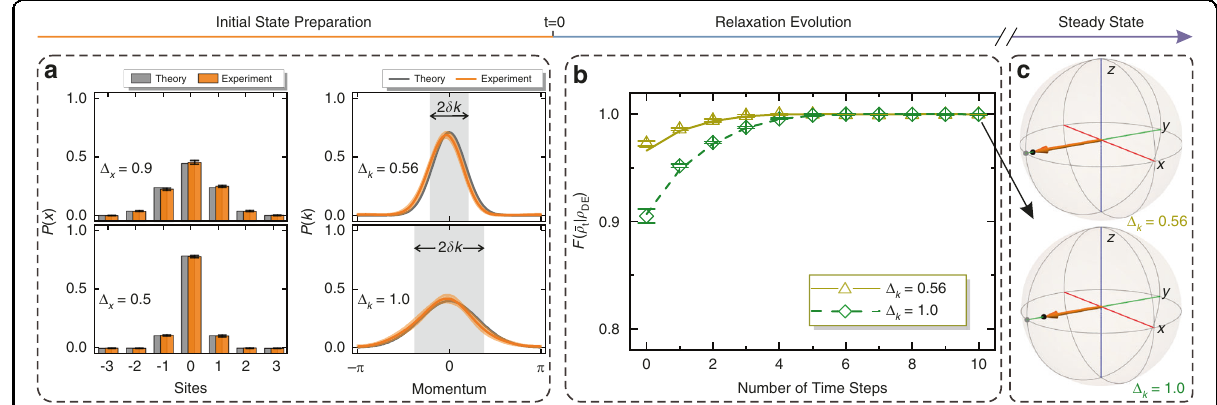
Fig. 3 Observing the spin subsystem equilibration. a Measured initial Gaussian distributions (orange bars in the left two panels) P ð x Þ with corresponding Δ x ¼ 0 : 9 and Δ x ¼ 0 : 5 in the lattice space, and the associated distributions (solid orange lines in the right two panels) Pð k Þ with corresponding Δ k ¼ 0 : 56 and Δ k ¼ 1 : 0 in momentum space. The gray bars and solid gray lines represent the theoretical simulations, and the gray ffiffiffiffiffiffiffiffiffiffi p ρ ρ Δ (yellow and green symbols) between the measured time- regions denote the width (2 δ k ¼ 2 2ln2 k ) of the distributions. b Fidelity Fð t j DE Þ averaged coin state and diagonal ensemble prediction at each time step starting from the prepared two-bath states coupling to the coin state # y The lines (solid yellow and dashed green) give the theoretical simulations. c Bloch sphere representations of the initial coin states (gray points), ten- step-averaged coin states (black points), and diagonal ensemble predictions (pointed by the orange arrows). All the error bars represent the statistical errors estimated by applying the Monte Carlo